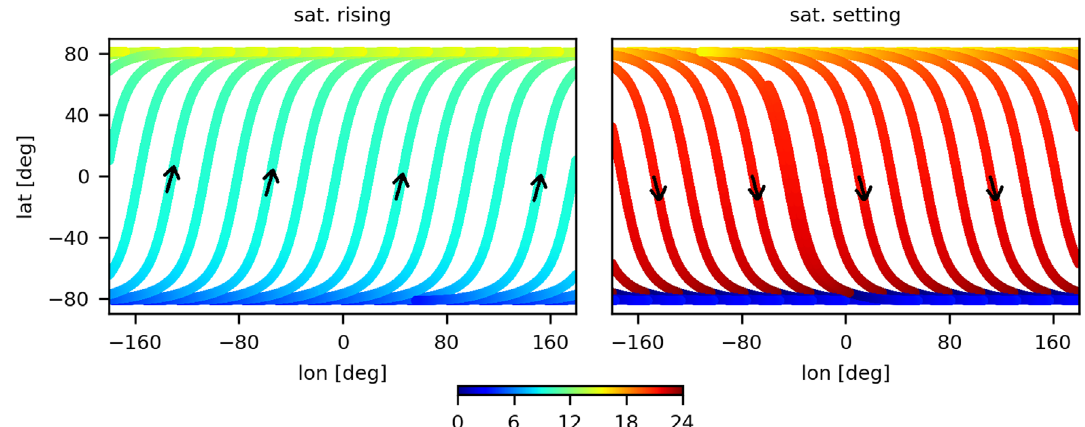
Fig. 2. METOP-A orbit footprints for DOY 076 of 2013 in terms of latitude, longitude and local time. Left panel shows the satellite rising phase and the right panel shows the setting phase. The unit of the color bar is